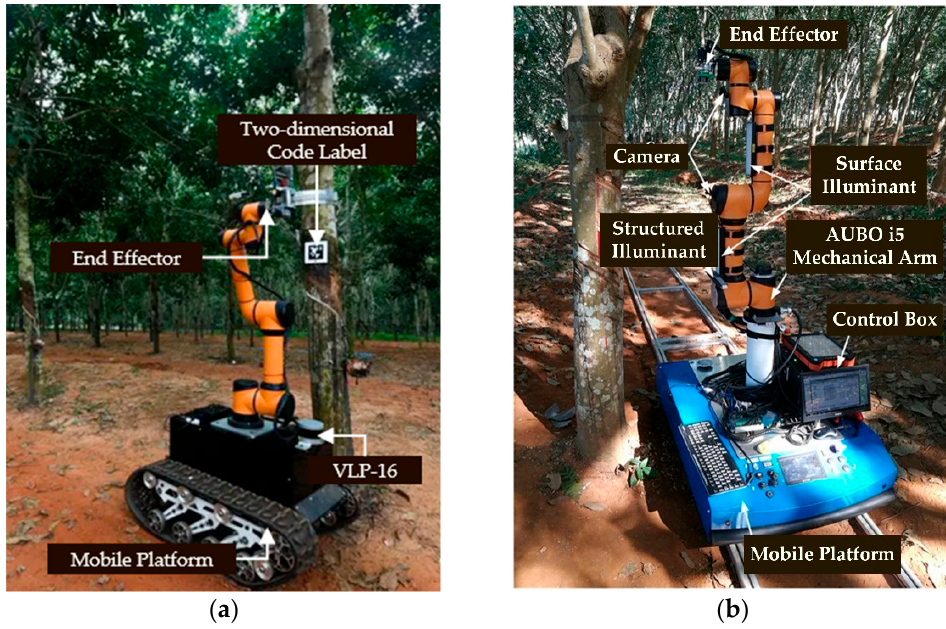
Figure 7. Self-propelled rubber tapping robot. ( a ) Crawler-type tapping robot [60] . ( b ) Rail-mounted tapping robot [18] .